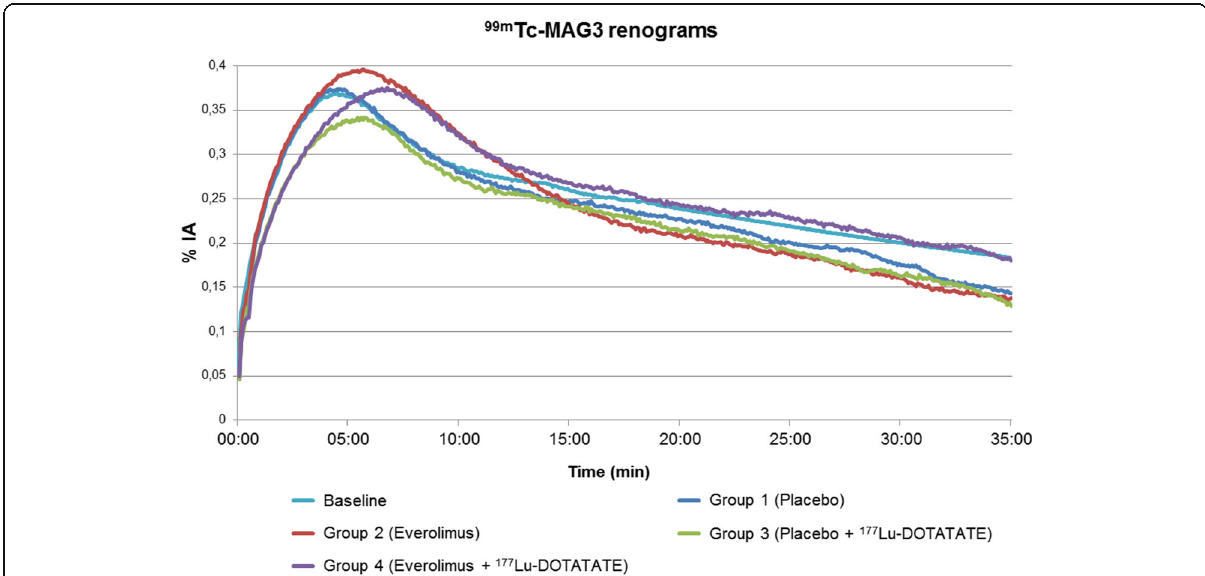
Fig. 1 Renograms at follow-up examination 16 weeks after the beginning of each treatment. Reduced steepness of the initial slope reflects impairment of renal function. For clarity, error bars are not shown. The baseline renogram is extrapolated to 35 min using a mono-exponential fit of the excretion